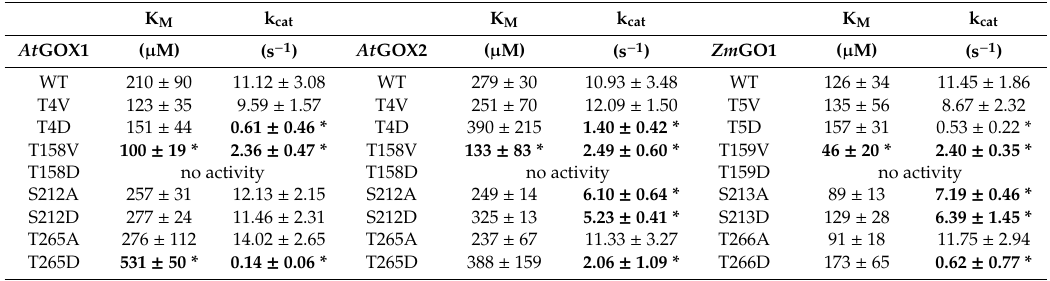
Table 2. E ff ect of phospho-site mutations on glycolate-dependent kinetic parameters of recombinant At GOX1, At GOX2 and Zm